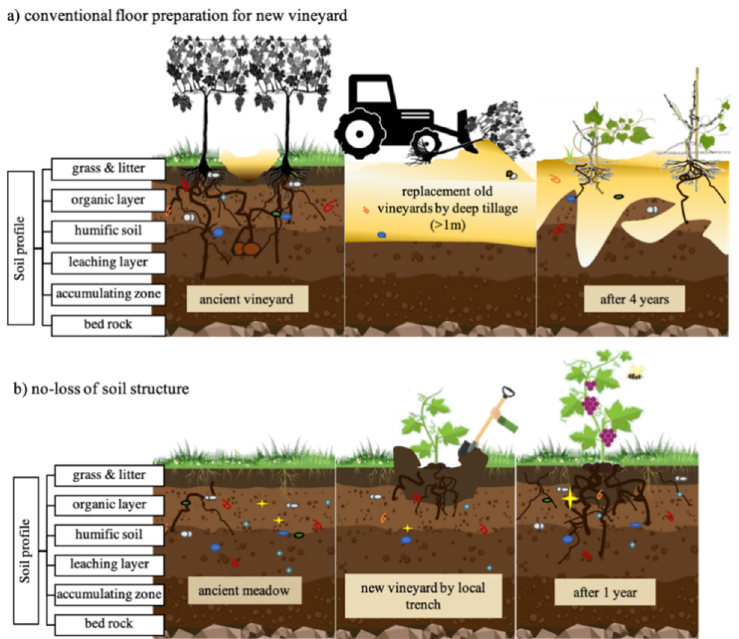
Figure 1. A cross-section of the soil profile in two different examples of management for starting new vineyards in hilly areas: ( a ) no land-use change, deep earthworks, and substitution of an ancient vineyard by implying a recovery time for soil functions and grape production >4 years [10]; ( b ) land-use change with the “Corino method” by maintaining the soil “heritage” using perennial meadows as the biological potential ecosystem service described in this study case (pre- and post-LUC).